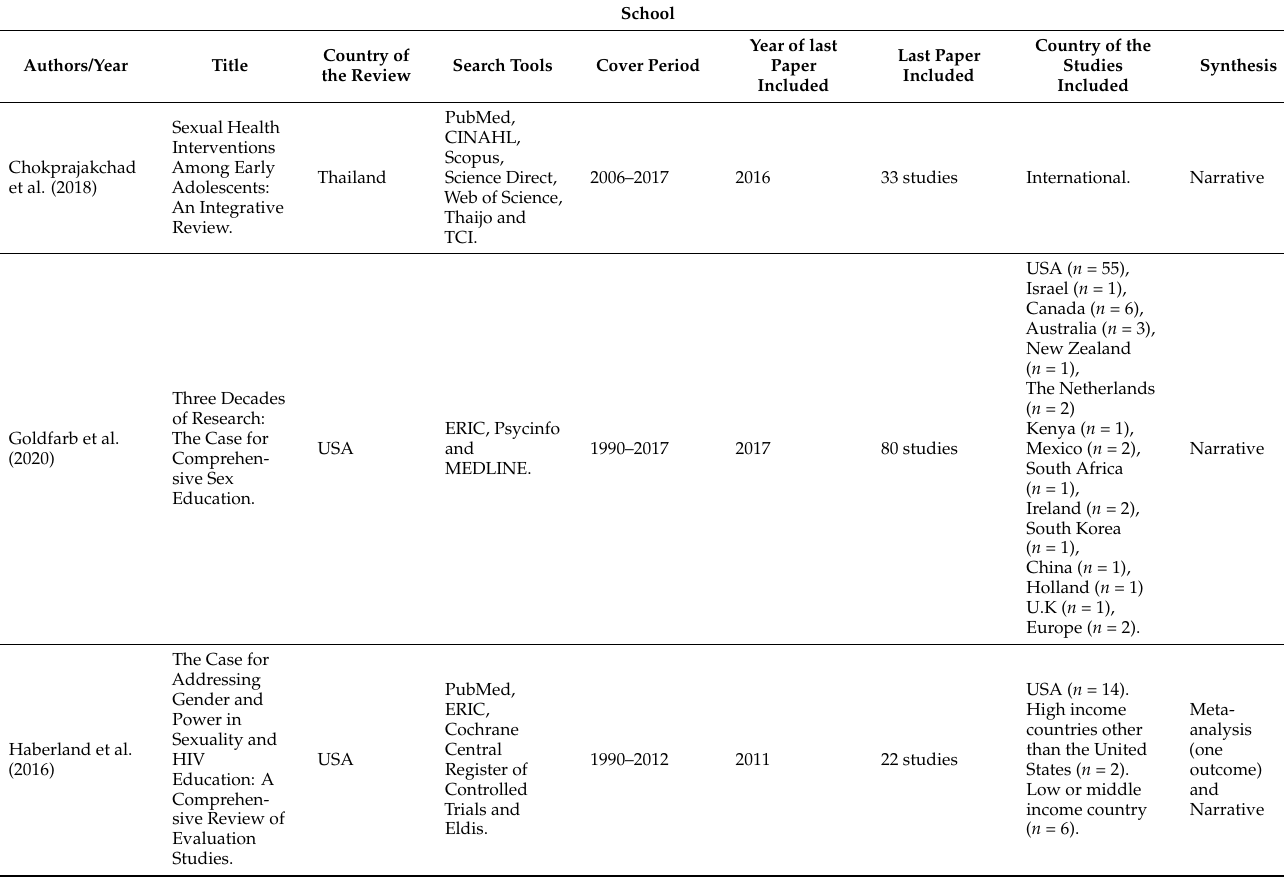
Table A2. Description of